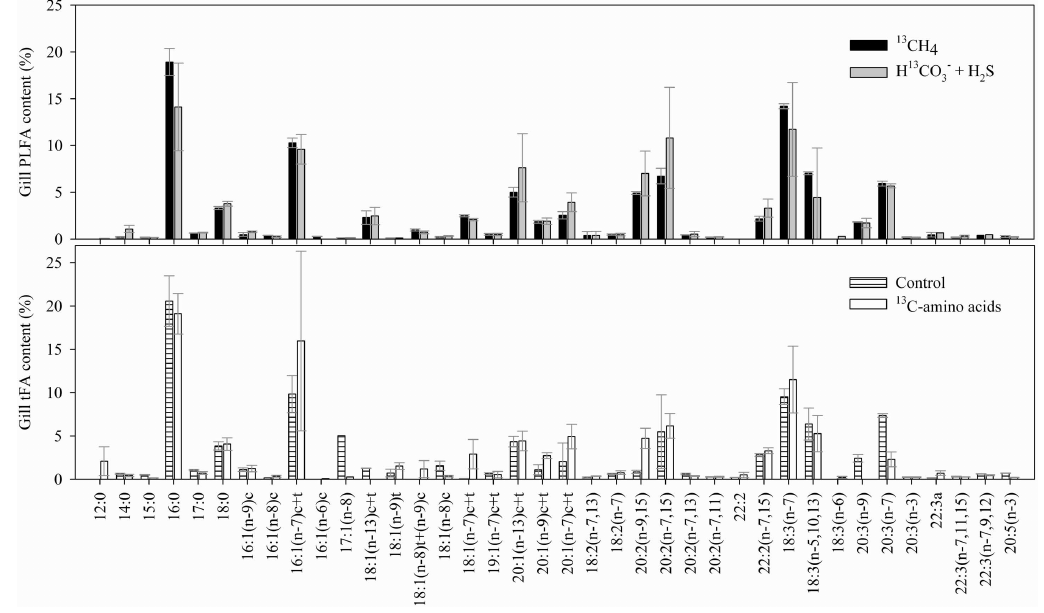
Fig. 4. Bathymodiolus azoricus gill tissue PLFA or tFA content ( n = 3, average ± standard deviation) after a 15 day supply with 13 CH 4 (black bars), or a 20 day supply with H 13 CO − in the presence of H 2 S (grey bars), or with 13 C-amino acids (white bars); striped bars represent 3 control